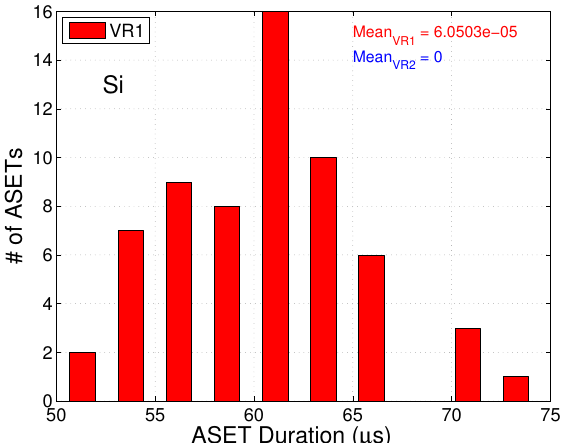
Figure 6. Measured number of ASETs versus ASETs duration for VR1 and VR2 circuits when exposed to